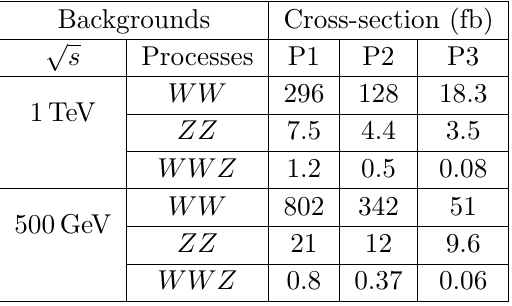
4. Production cross-sections for W + ( ‘ + ν ) W − ( ‘ − ¯ ν ) , Z ( ‘ + ‘ − ) Z ( ν ¯ ν )